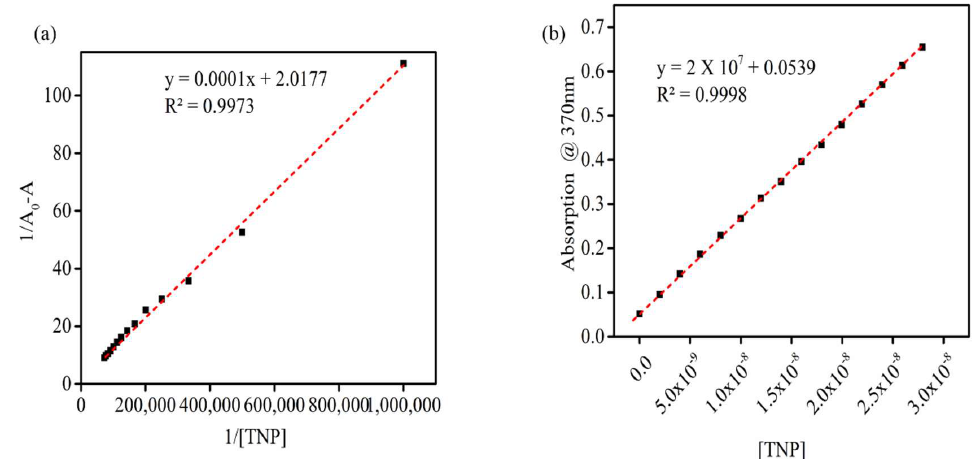
Figure 5. ( a ) Benesi–Hildebrand plot of 1 and TNP ( A1 ); and ( b ) absorption intensity at 370 nm of 1 versus increasing concentration of TNP ( A1 ). versus increasing concentration of TNP ( A1